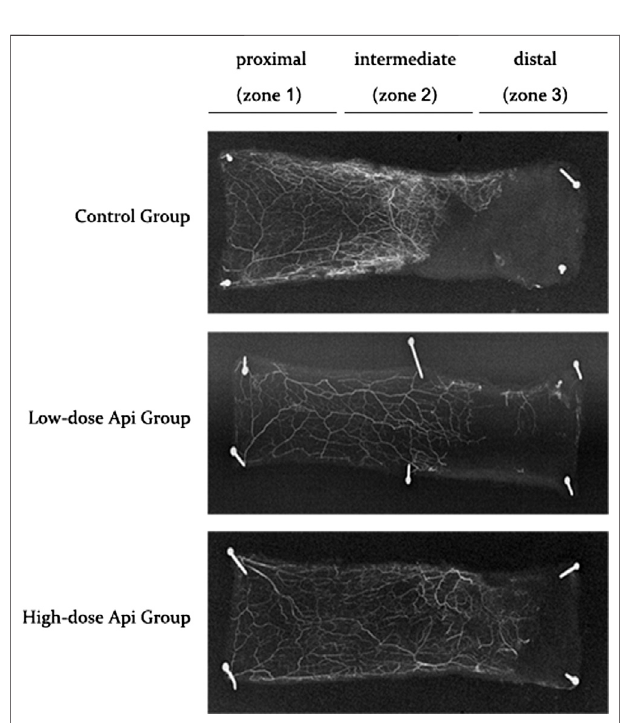
FIGURE 5 | X-ray angiography of the fl aps in the control, low-dose Api, and high-dose Api groups on day 7 after the operation. Api improved fl ap angiographic